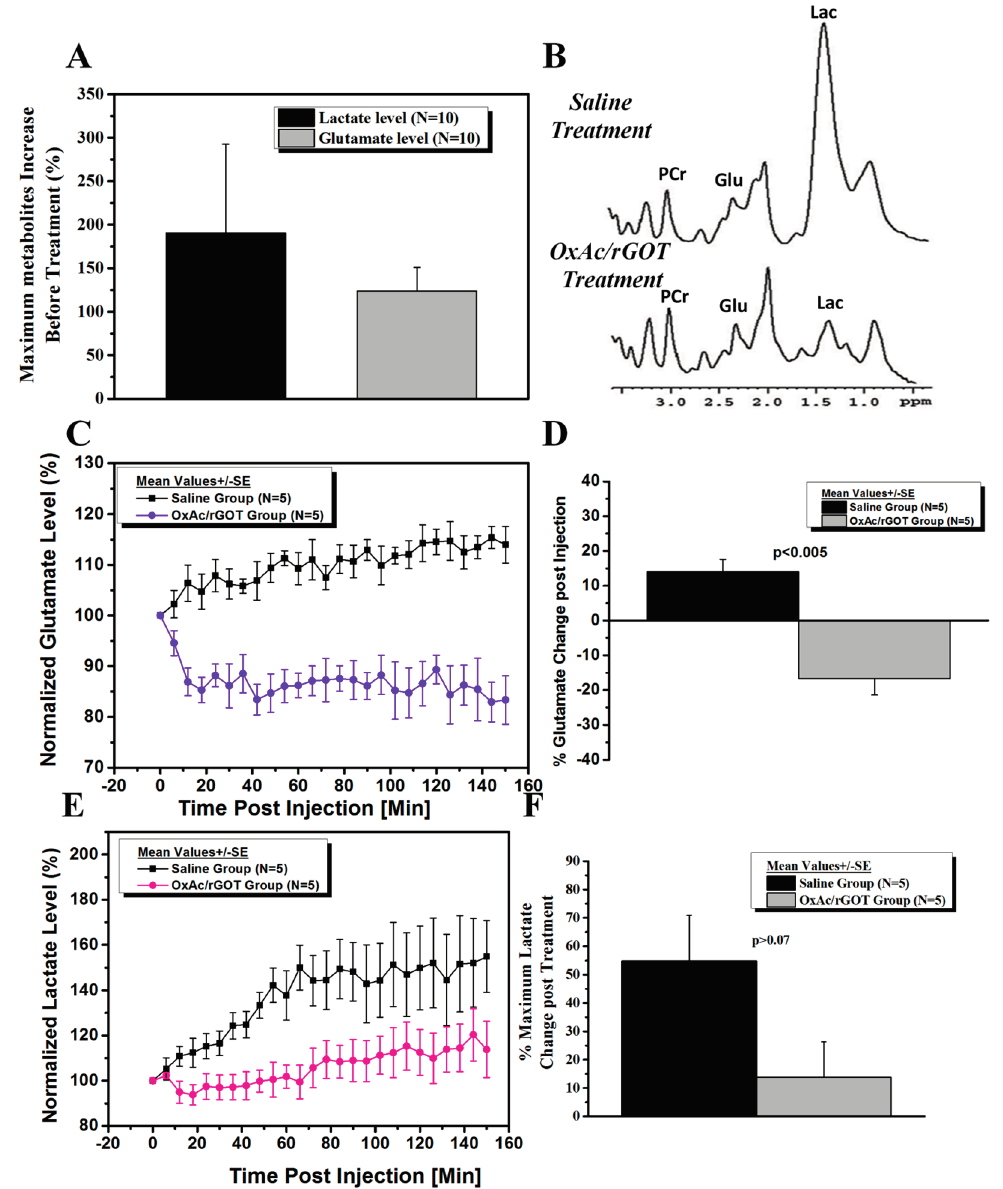
Figure 2. ( A ) Post PO exposure before treatment, lactate and glutamate levels increased in comparison with baseline values before the exposure to PO. Data were expressed as mean ± S.E. p < 0.05 for both metabolites as determined by t -test (in comparison with baseline values); ( B ) Representative in vivo proton MRS spectra in the hippocampus after OxAc/rGOT and saline treatments at the latest MRS time point. Lactate (Lac) is resolved at 1.3 ppm, glutamate (Glu) at 2.2 ppm and phosphocreatine (PCr) at 3.0 ppm; ( C ) Normalized glutamate levels in the hippocampus after OxAc/rGOT and saline treatments as a function of time. Data were expressed as mean ± S.E. p < 0.005 as determined by t -test; ( D ) The hippocampus glutamate levels after the OxAc/GOT or saline treatments at the end of the experiment; ( E ) Normalized lactate levels in the hippocampus after OxAc/rGOT and saline treatments as a function of time; ( F ) The hippocampus lactate levels after the OxAc/GOT or saline treatments at the end of the experiment. Data were expressed as mean ± S.E. p < 0.04 as determined by t